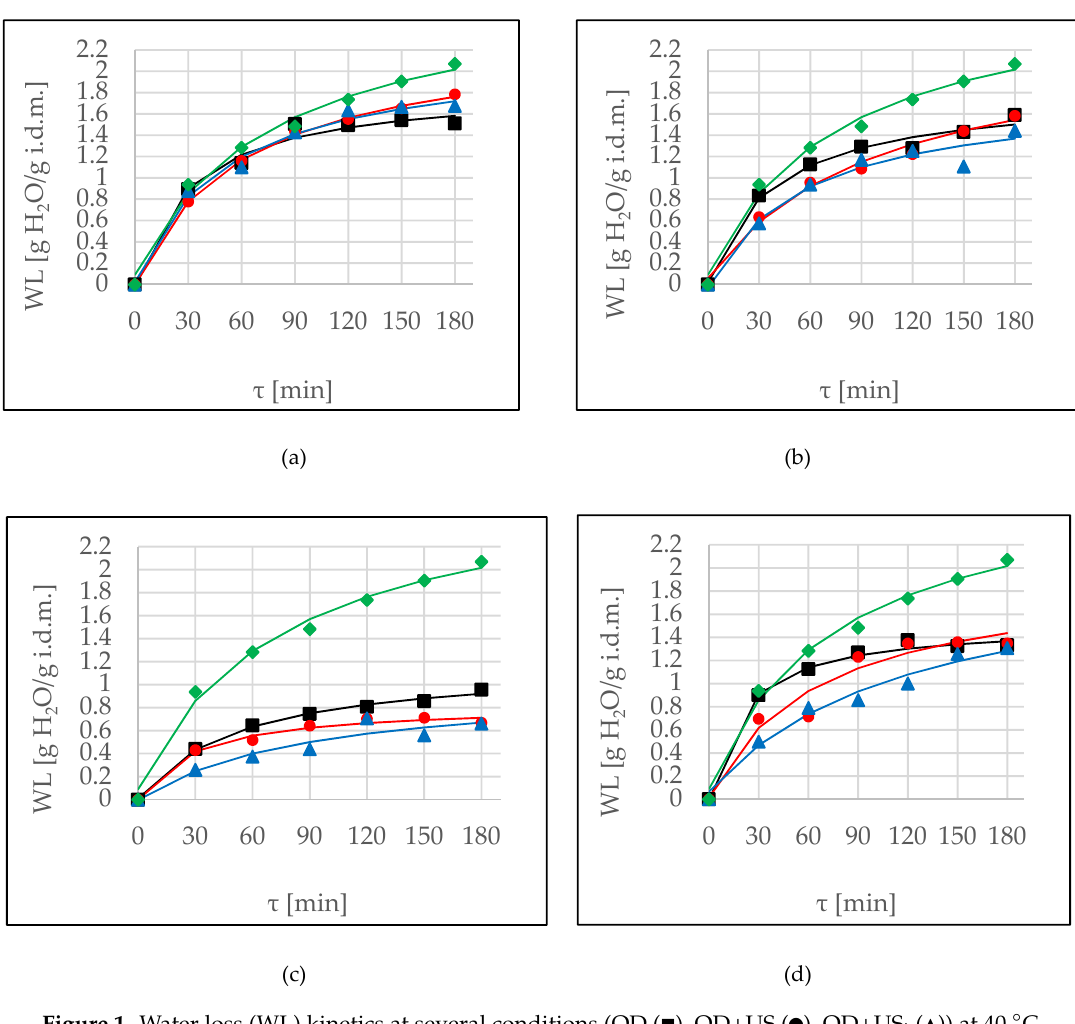
Figure 1. Water loss (WL) kinetics at several conditions (OD ( ■ ), OD+US ( ● ), OD+US i ( ▲ )) at 40 °C, in different solutions: ( a ) erythritol, ( b ) xylitol, ( c ) maltitol, ( d ) DHA. Lines are the Peleg’s model. The green line ( ♦ ) is the kinetic reference (sucrose).